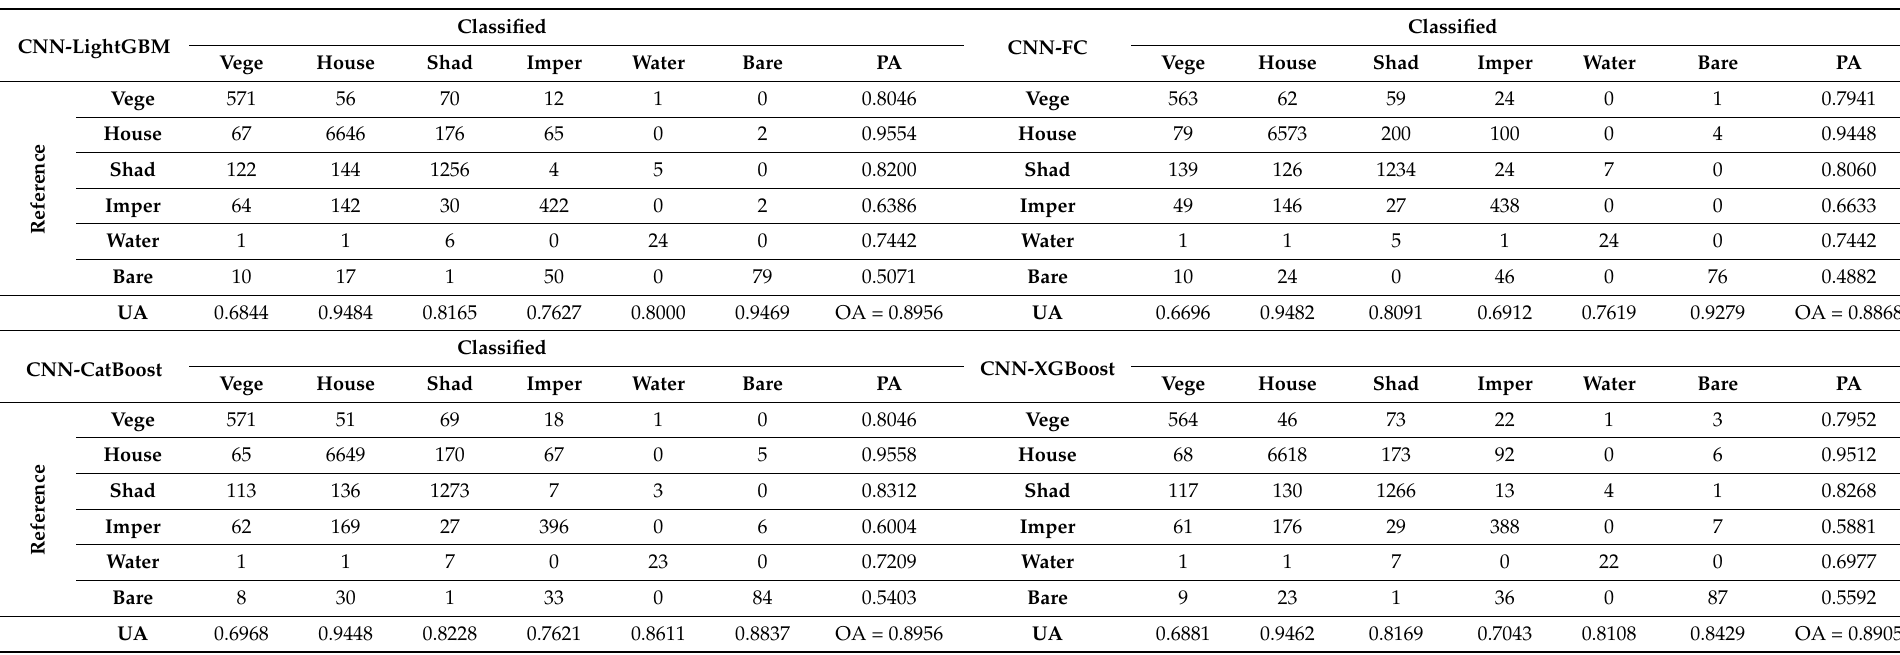
Table 5. Confusion matrix of the CNN-based gradient boosting methods. PA: Producer’s Accuracy, UA: User’s Accuracy, OA: Overall